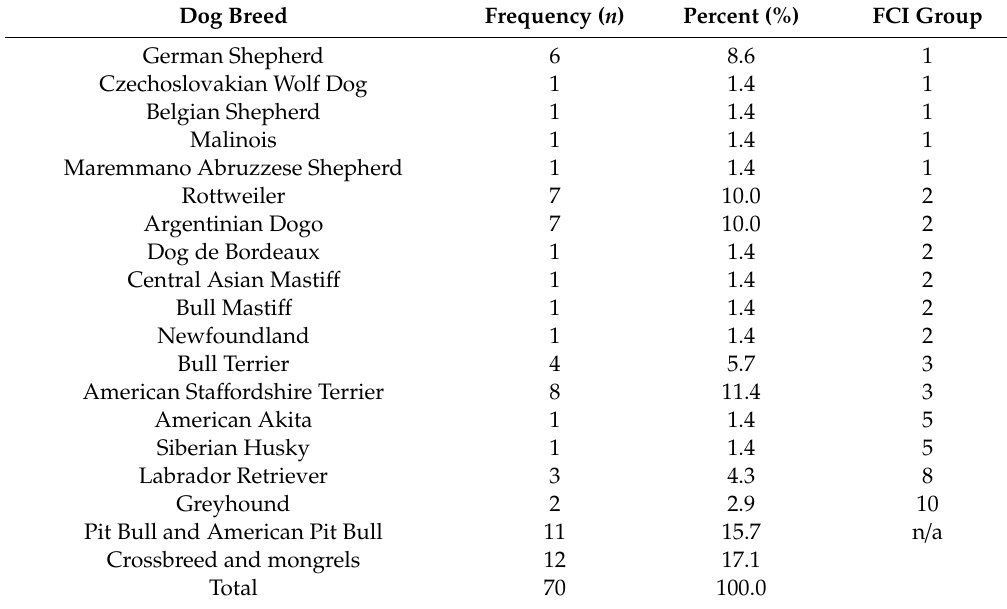
Table 5. Breed distribution and correspondent Federation Cynologique International (FCI) group of dogs aggressive towards other